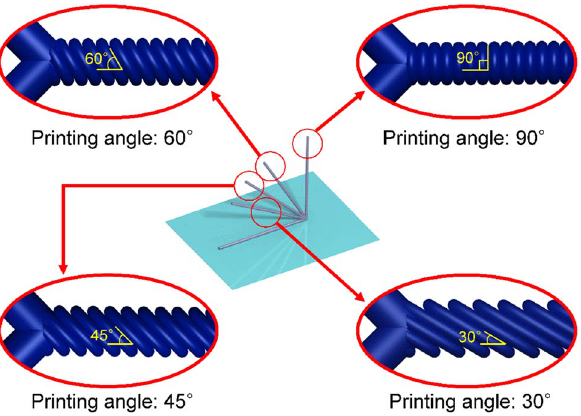
Figure 1. Schematic of the mixing channel molds printed by a 3D printer with various printing